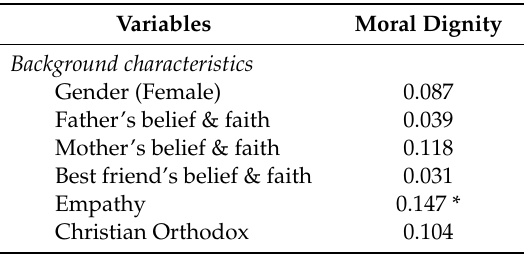
Table 8. Regression analysis for moral dignity with weights ( β ) for each variable and total explained variance ( R 2 and adjusted R 2